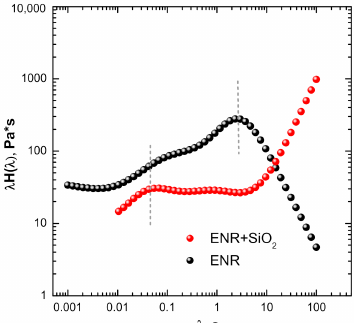
Figure 3. “Weighted” relaxation spectra for ENR and ENR + SiO 2